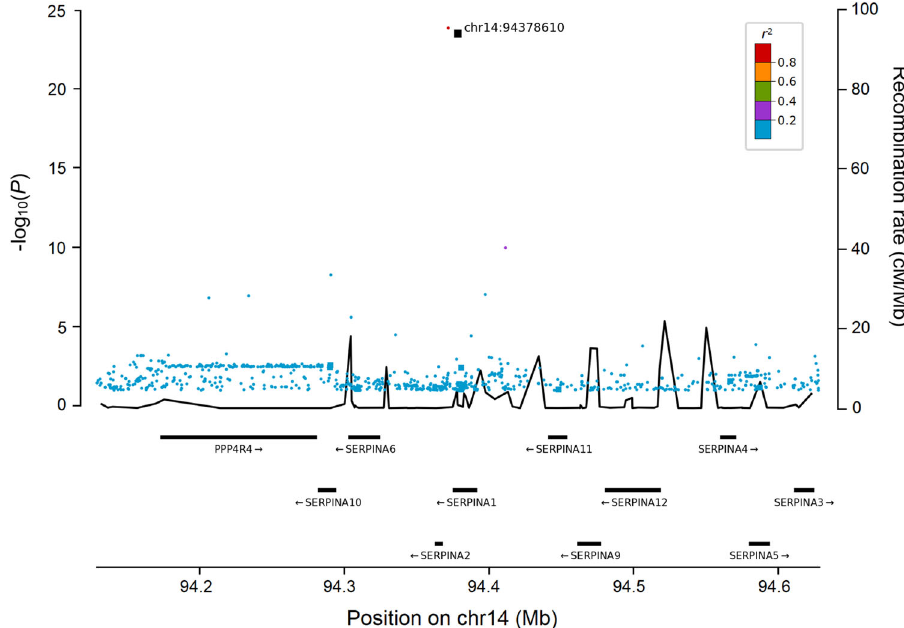
Fig. 4 Regional plot of the SERPINA1 locus. Variants are colored by the degree of correlation ( r 2 ) with the lead variant, which is colored black. Moderate impact variants are represented by squares. The -log 10 P -values on the left y-axis (two-sided logistic regression) are plotted for each variant against their chromosomal position (x-axis). The right y-axis shows calculated recombination rates based on the Icelandic data at the chromosomal location, plotted as solid black